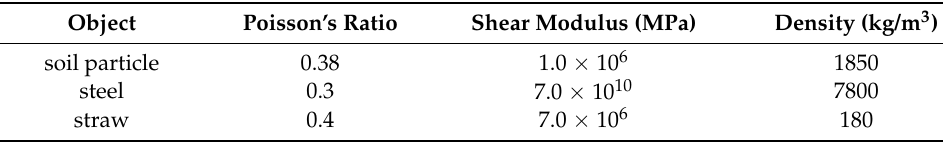
Table 1. Physical parameters of materials.